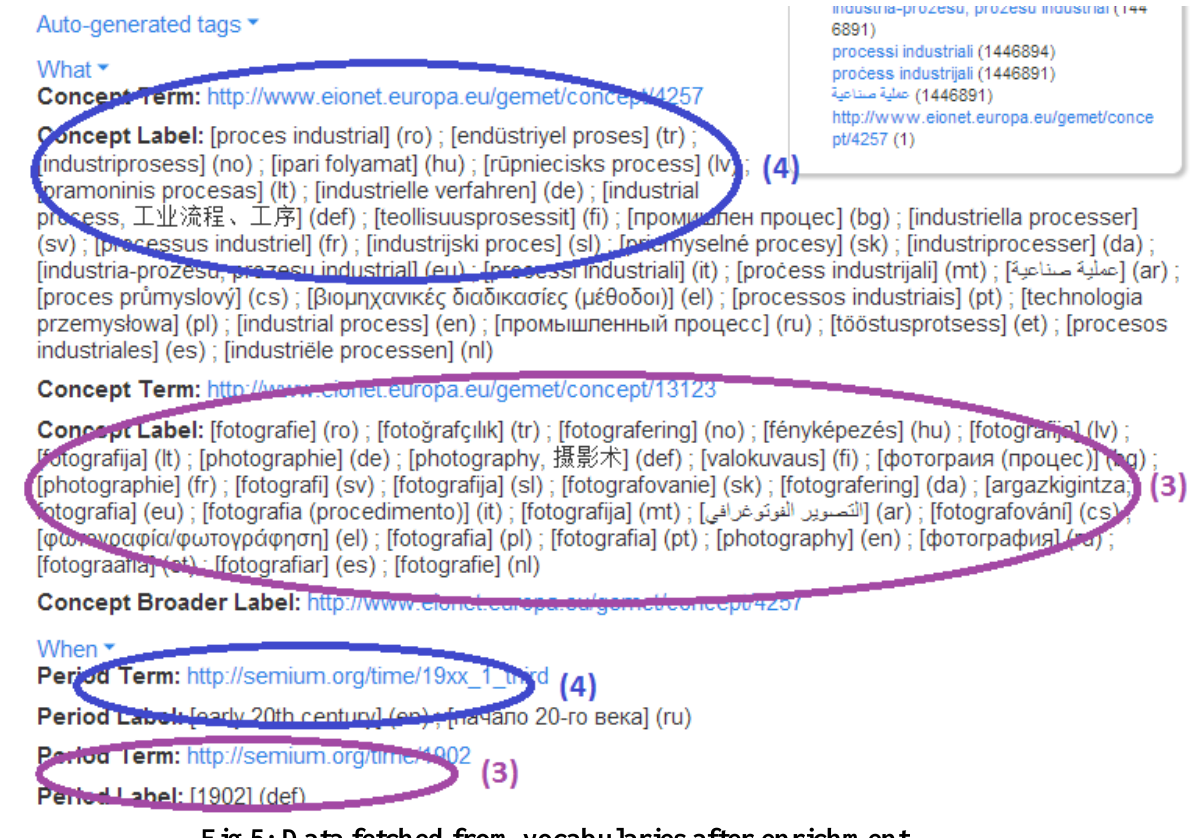
Fig 5: Data fetched from vocabularies after